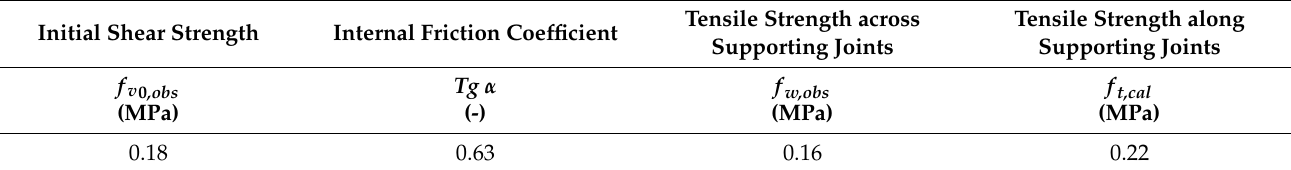
Table 5. Characteristic values of mechanical properties for the tested partition walls.